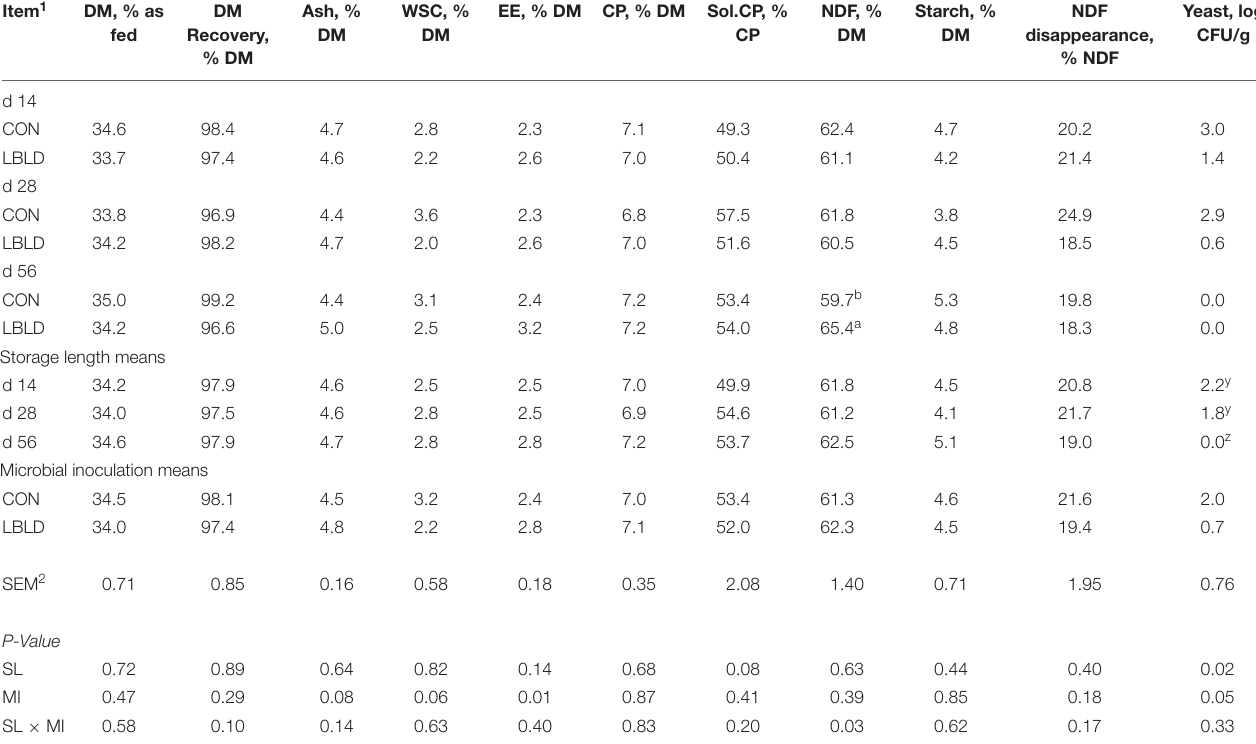
TABLE 9 | Effect of microbial inoculation and storage length on the nutrient composition and yeast counts of whole-plant sorghum-sudangrass silage in experiment 2. Item